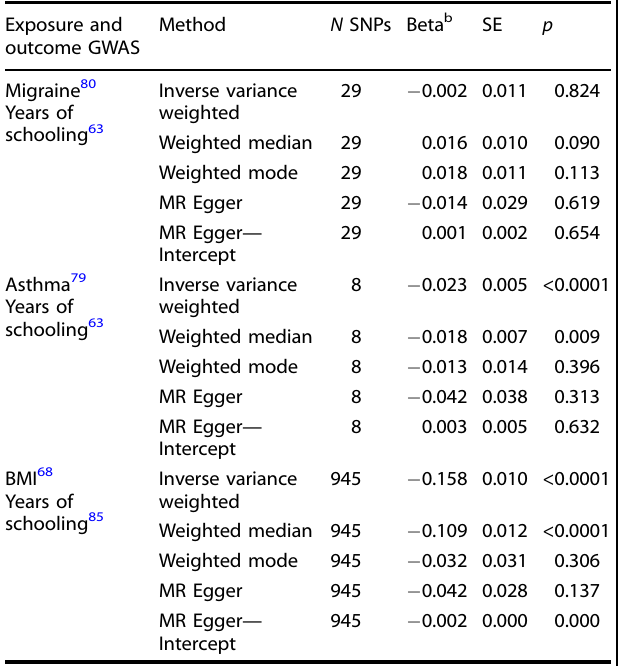
Table 5. Results from two-sample summary-level Mendelian randomization a